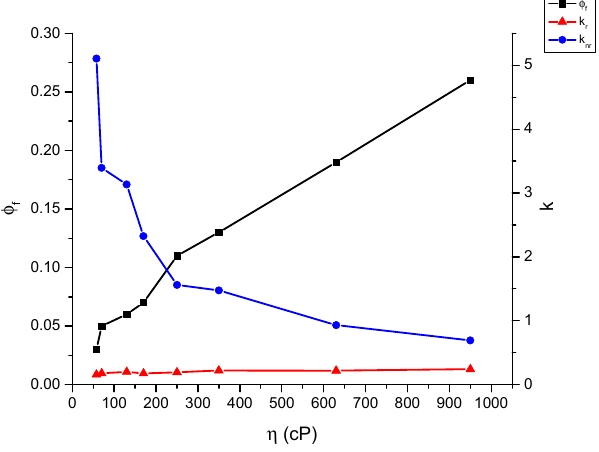
Figure 6. Fluorescence quantum yield ( Φ f ), radiative ( k r ), and non-radiative ( k nr ) rate constants of dU-BZ obtained as a function of viscosity ( η ) in glycerol/methanol solutions. From Equation (7), a straight line was obtained in the plot of log τ f vs . log η and, as expected, linear behavior was obtained (Figure 7) with a slope, α , of 0.59 ± 0.04, consistent with the value predicted by the Förster-Hoffmann equation, and a R 2 value of 0.96 for dU-BZ. It was also found that plots below 58 cP fit in the same straight line, but lifetime values lower than 0.2 ns were not reliable due to the resolution of the experimental system (Table 2). Only plots from 58 cP to 950 cP are shown in the figure.